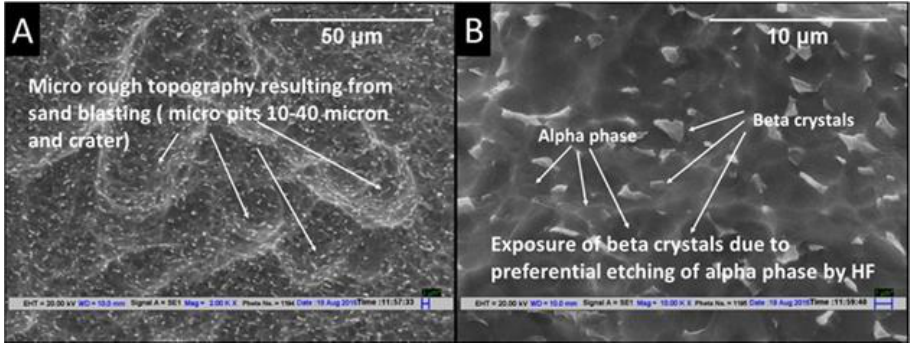
Figure 3. SEM images of sandblasted dental implant acid-etched with HF for 30 s at room temperature at ( A ) 2000× and ( B ) 5000×.